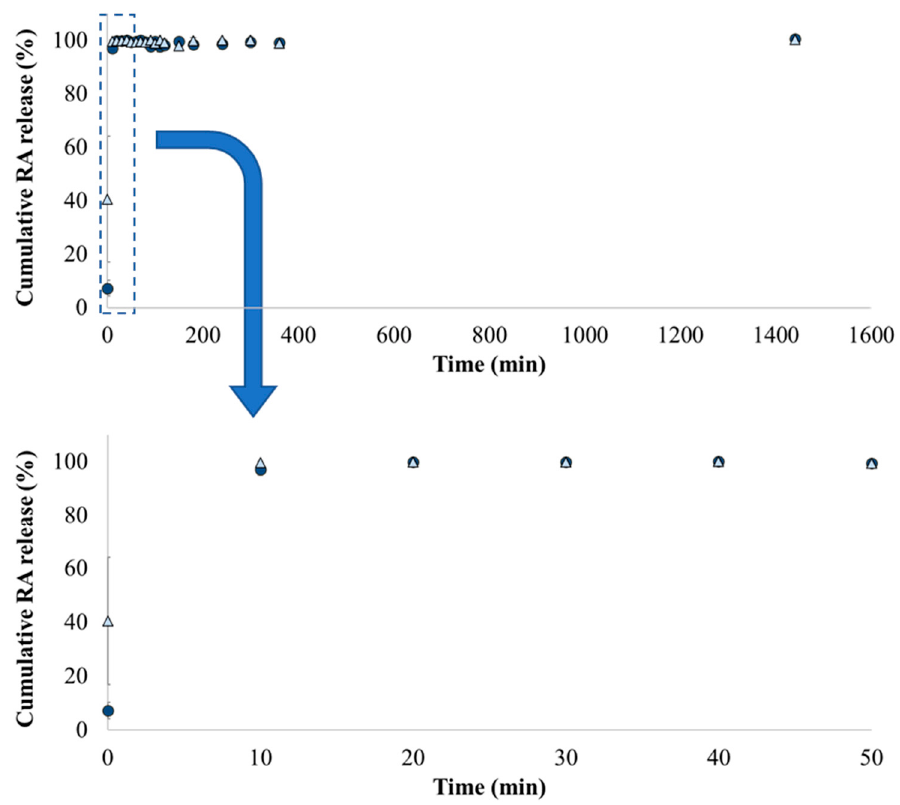
Figure 3. Cumulative release of RA from polymer-microparticles composed by EC (dark blue circles) and by the EC + PEG blend (light blue triangles). Results are presented as the average and standard deviation of three independent assays.